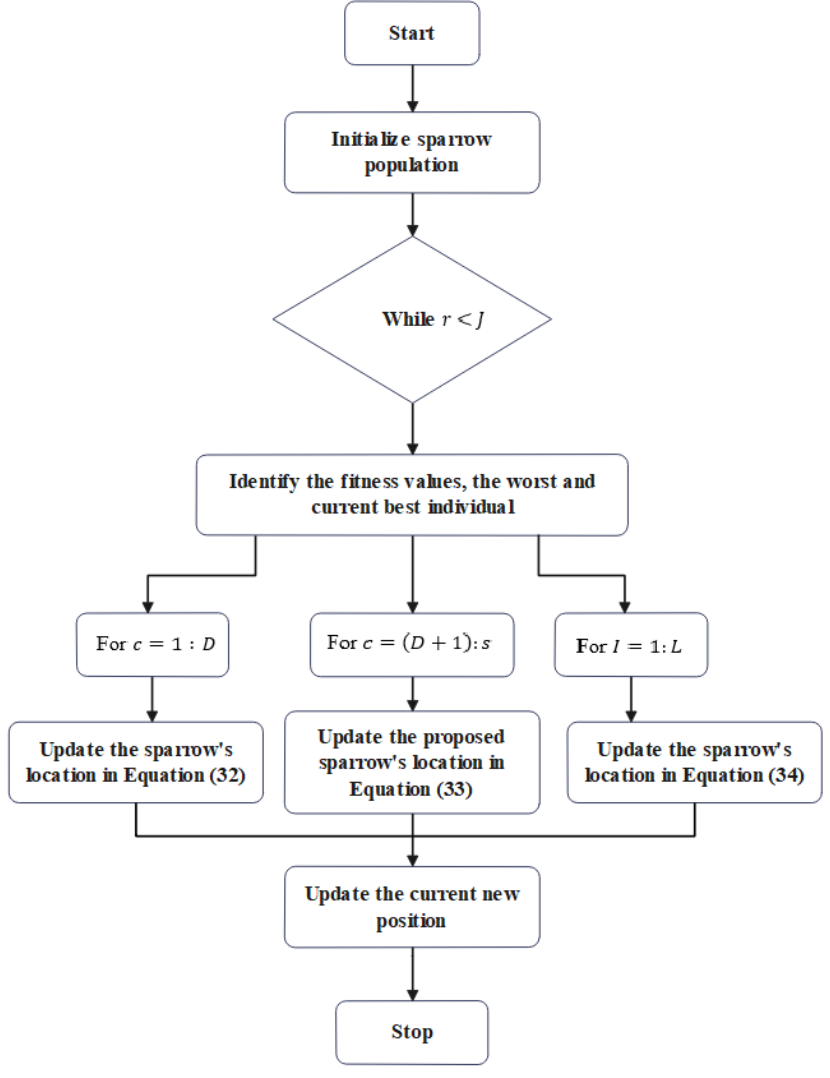
Figure 2. Flowchart of BEA-SSA